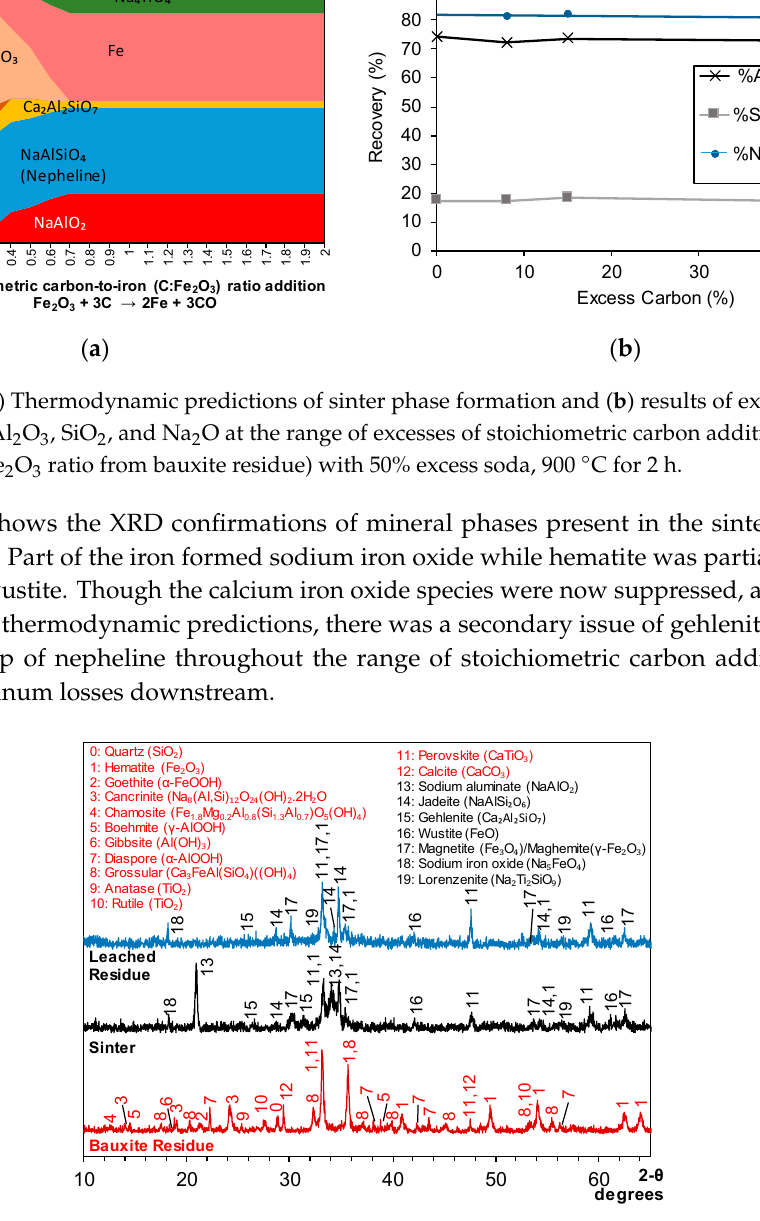
Figure 11. XRD of mineralogical phases for stoichiometric carbon addition needed to produce Fe from Reaction (5), with 50% stoichiometric excess Na 2 CO 3 at inert conditions at 900 °C and for 2 h. Red font: Existing minerals in bauxite residue; black font: Transformed sinter and leached minerals.